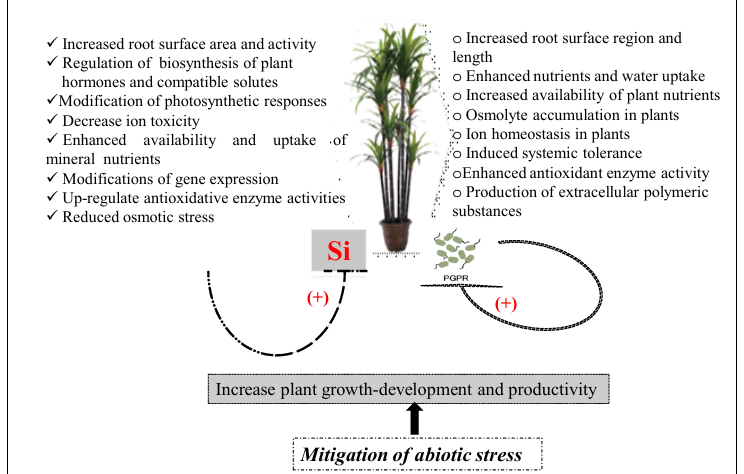
Figure 2. The mechanisms by which Si and PGPRs mitigate abiotic stress in plants.